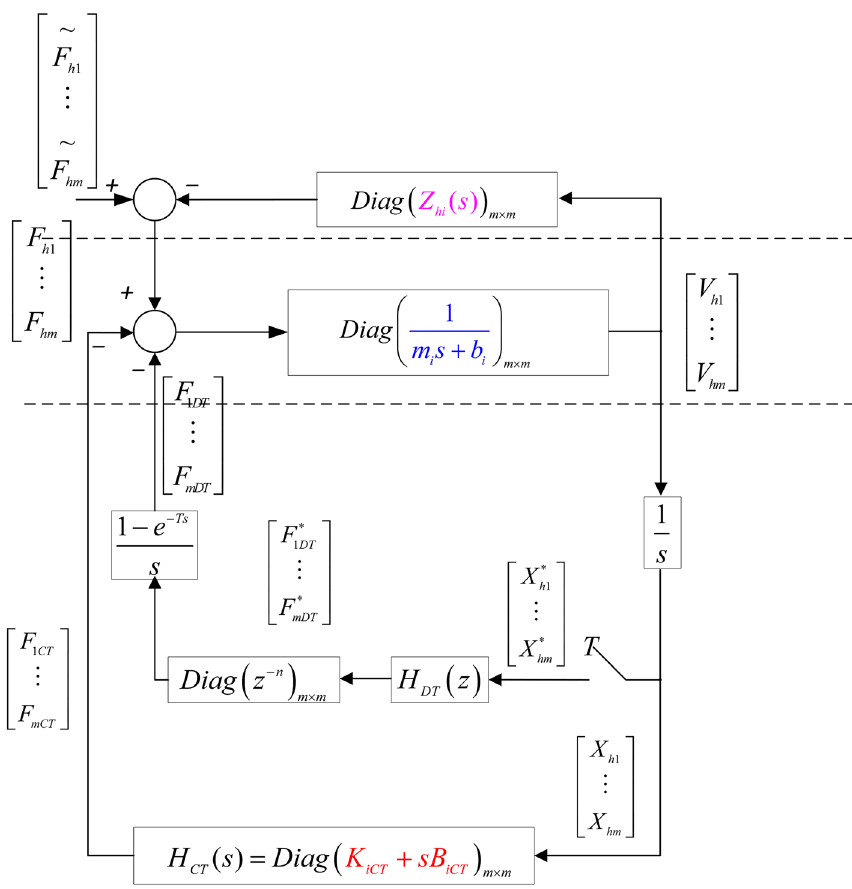
Figure 5. Model of a one-dimensional multiple-user haptic virtual surgery simulation system with the analogue